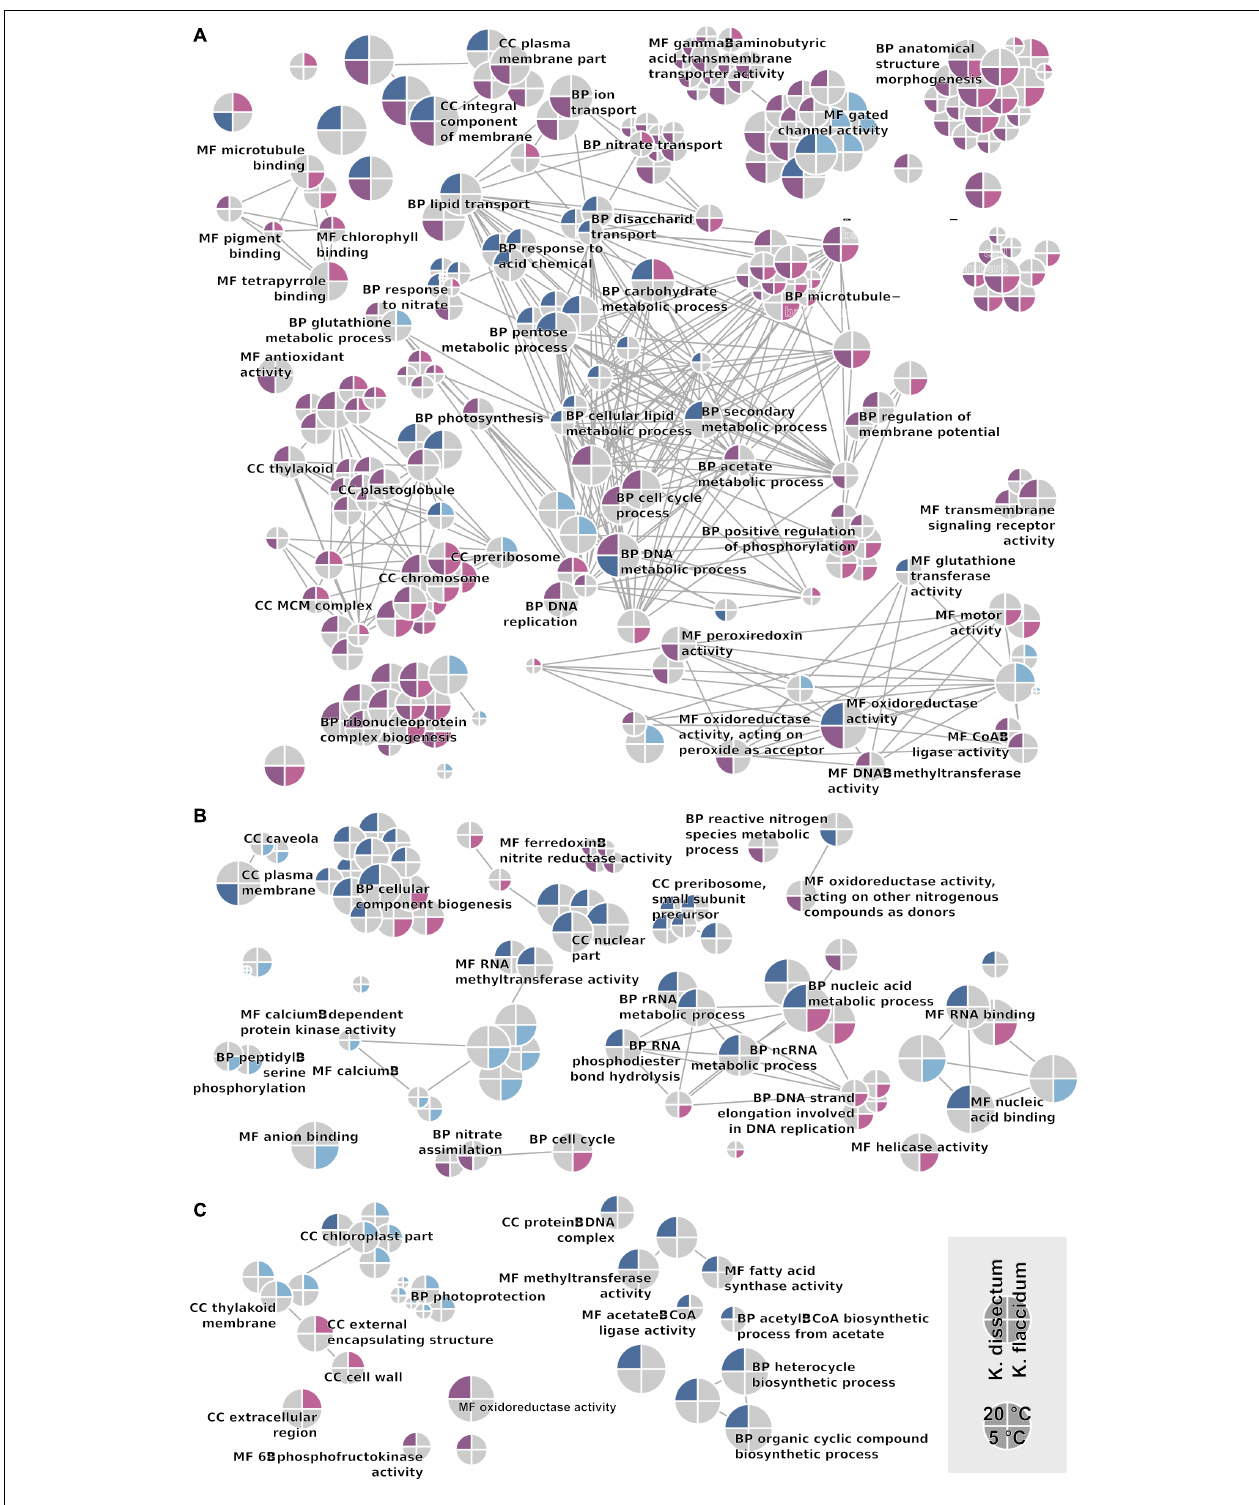
FIGURE 8 | GO network displaying all enriched categories in both Klebsormidium species. Terms regulated at 5 ◦ C are indicated as the lower half of the circle, while terms regulated at 20 ◦ C are depicted in the upper half. Upregulation and downregulation are indicated with blue and red colors. K. dissectum is on the right while K. flaccidum is on the left side. The root categories are “biological process” (BP), “molecular function” (MF), and “cellular component” (CC). Edges depict shared higher categories. (A) Comparison of control cells with desiccated cells. (B) Comparison of desiccated cells with cell rehydrated for 2 h. (C) Comparison of cells with short (2 h) and long rehydration (24 h after start of the experiment) periods.